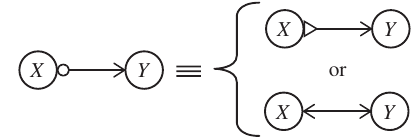
FIG. 6. Shortcut graphical notation for any causal link with no direct cause from Y to X .